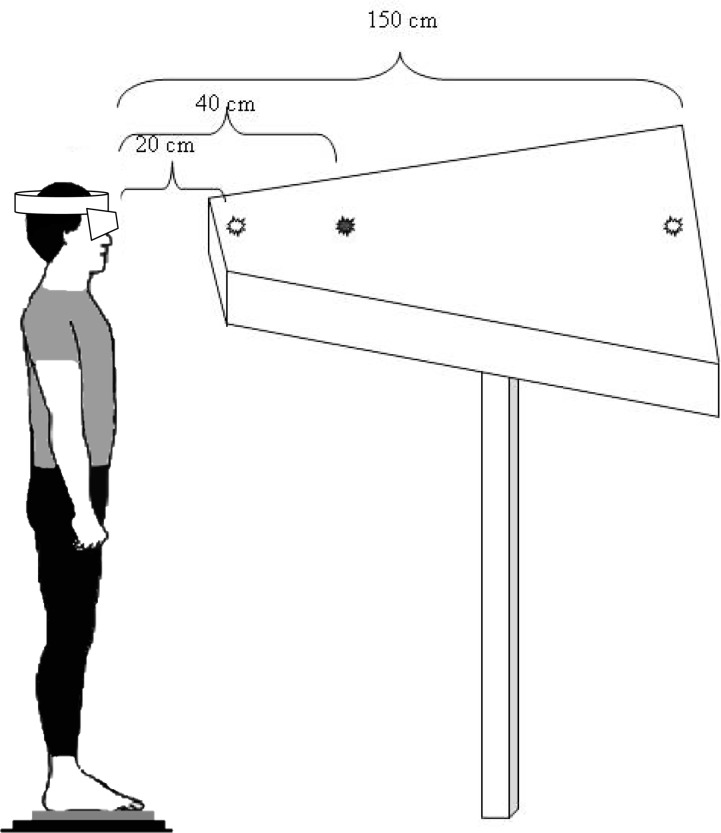
Visual target and eye movement recording.The subject is standing on a force platform, staring at the LEDs successively lit, which results in convergence and divergence eye movements.